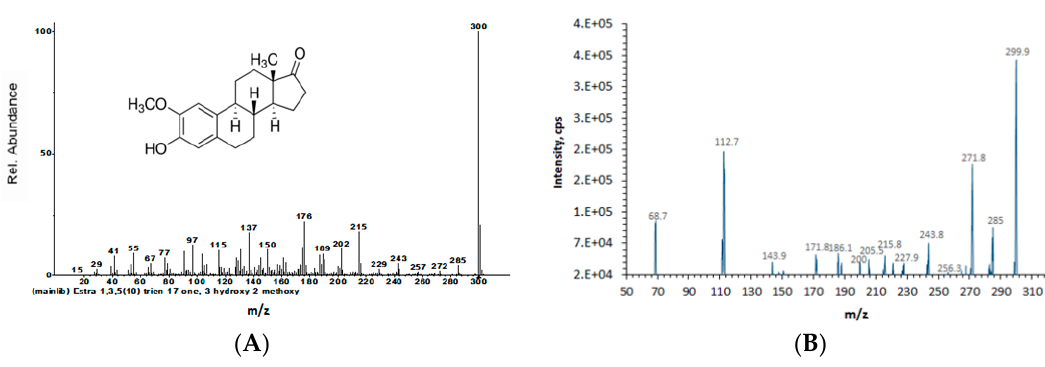
Figure 4. Relevant tandem mass (MS/MS) spectra. ( A ) 2-Methoxyestrone (from NIST 14 mass spectral library); ( B ) isolated and purified compound ( 2 ).